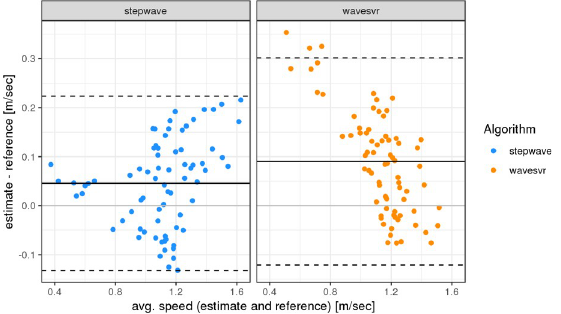
Fig 4. Bland-Altman plots of the applied algorithm combinations. The plot for the original speed algorithm wavesvr and stepwave. The solid horizontal lines are the mean differences between estimated and reference speed, and the dashed lines the 1.96 fold standard